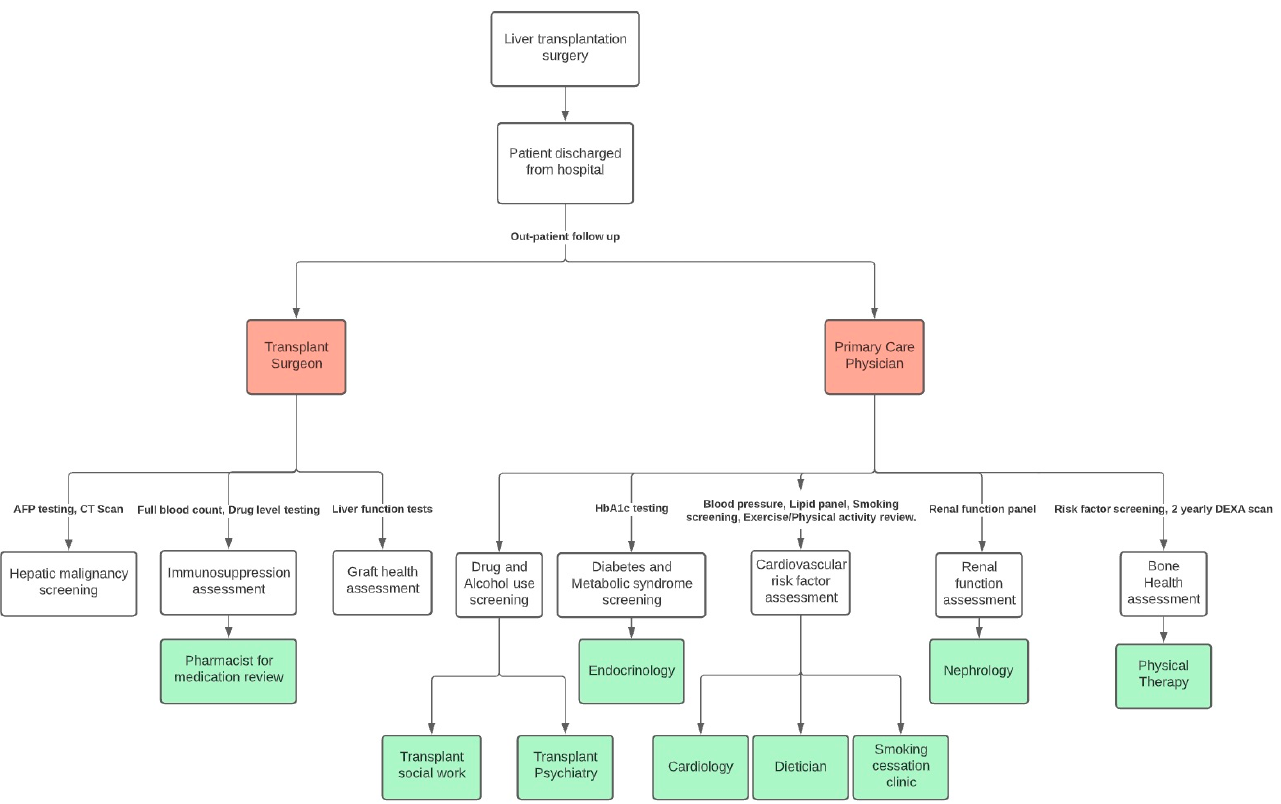
Figure 1. Flow chart demonstrating the summary of the multidisciplinary team approach to whom referral should be considered based on indication and assessment.